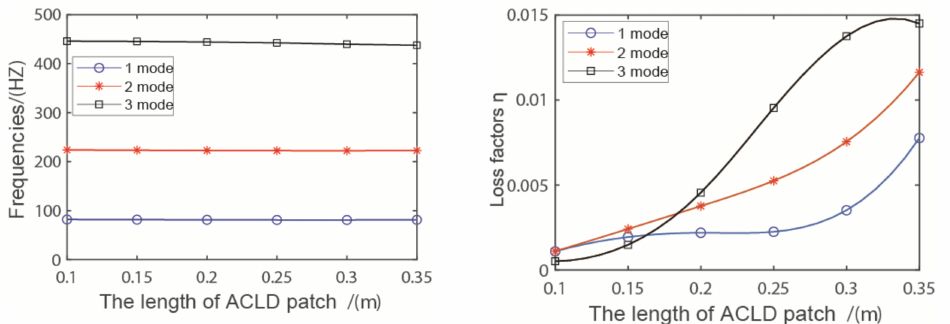
Figure 11. Influence of the length of the ACLD patch.